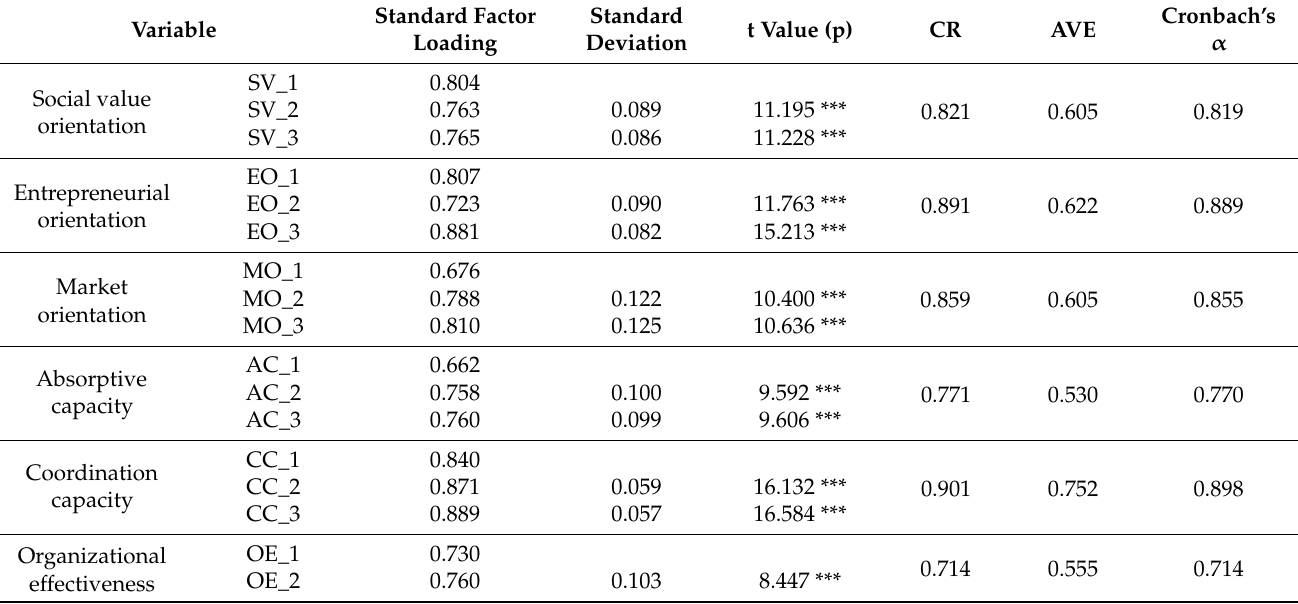
Table 3. Results of reliability and convergent validity test.